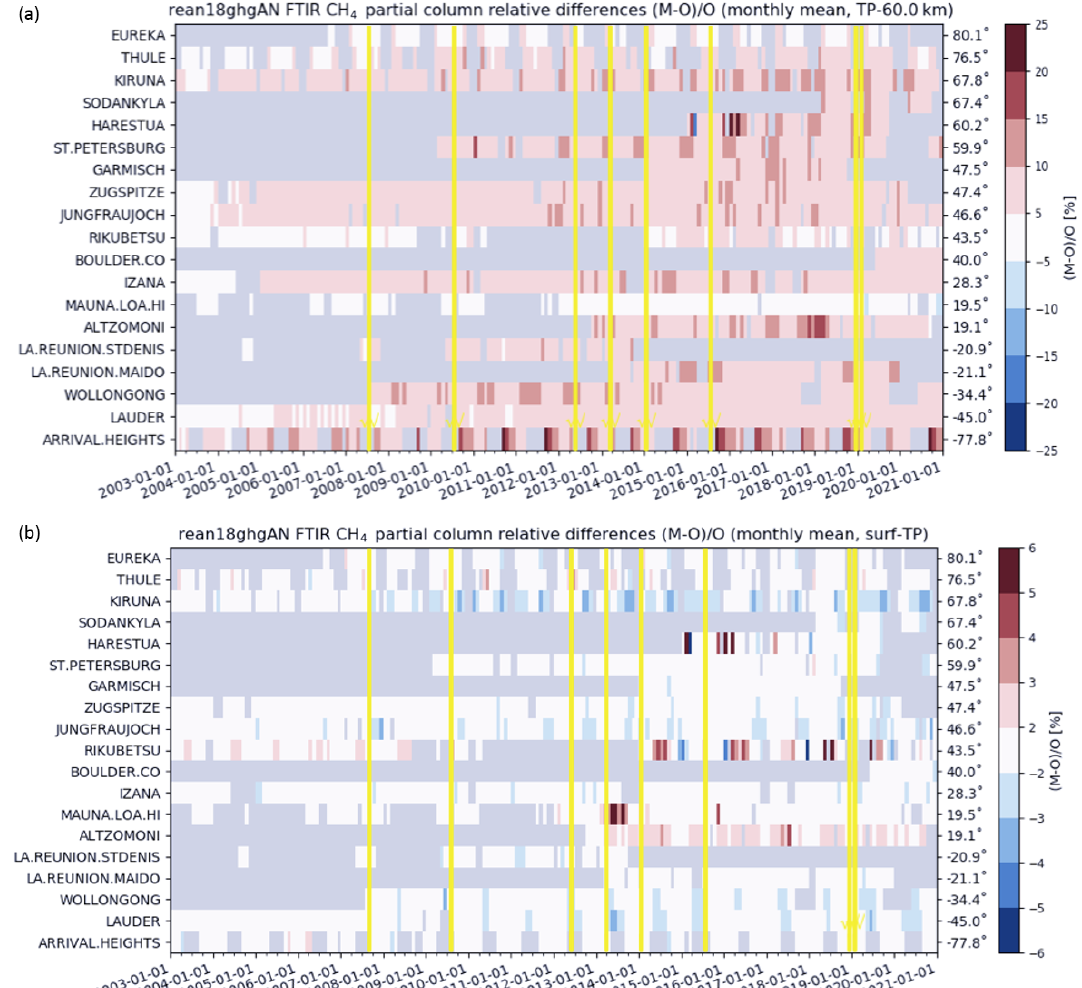
Figure 11. Mosaic plot of seasonal relative CH 4 biases at all FTIR sites (see Table A2) for the stratospheric columns (a) and tropospheric columns (b) from NDACC. Vertical yellow lines depict the changes in the assimilated data documented in Figs. 1, 5 and 6. Grey shading indicates no observations are